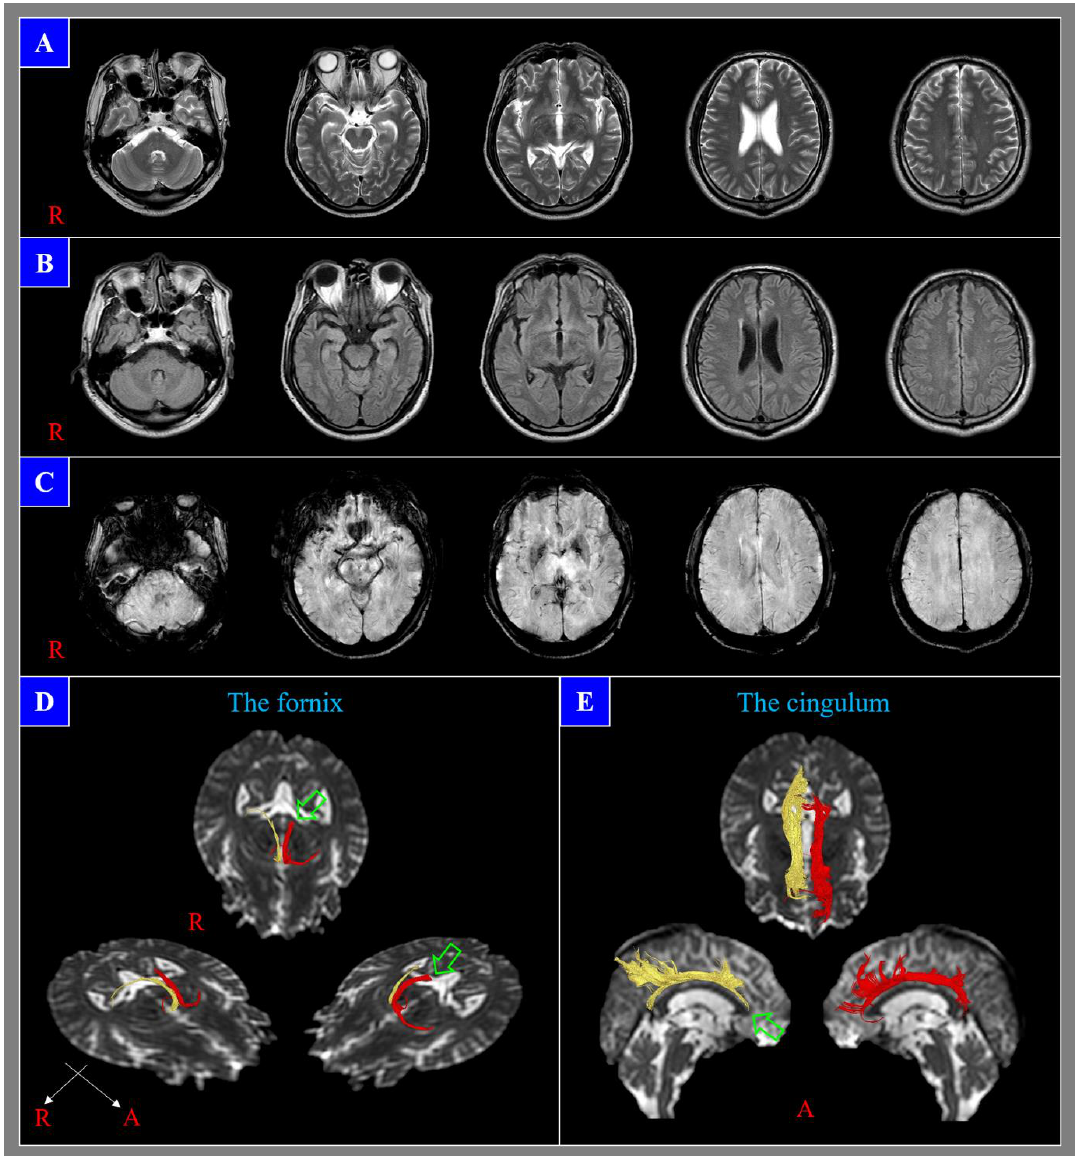
Figure 1. A 54-year-old male who showed loss of consciousness for seven days after a pedestrian–car accident does not show any lesions in ( A ) T2-weighted, ( B ) fluid attenuation inversion recovery (FLAIR), and ( C ) susceptibility-weighted imaging (SWI). However, diffusion tensor tractography results show neural injuries (discontinuations (green arrows): the left fornical crus and right anterior cingulum) of the fornix ( D ) and cingulum ( E ); these injuries are consistent with the subject’s cognitive impairment, which developed after head trauma.